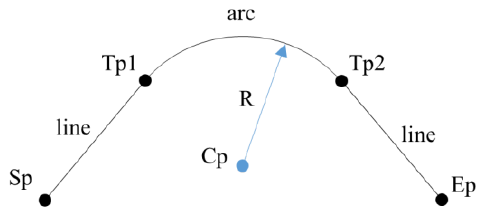
Figure 3. Line-arc-line curve model and parameters.